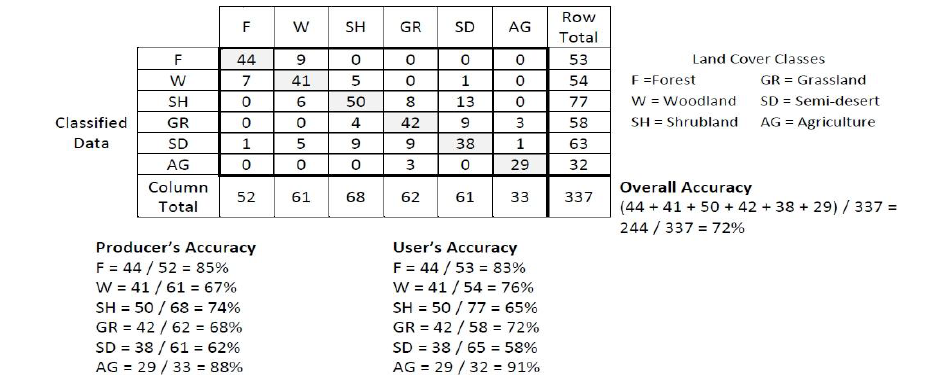
Fig.17: Example error matrix with producers, users, and overall accuracy calculations [6].